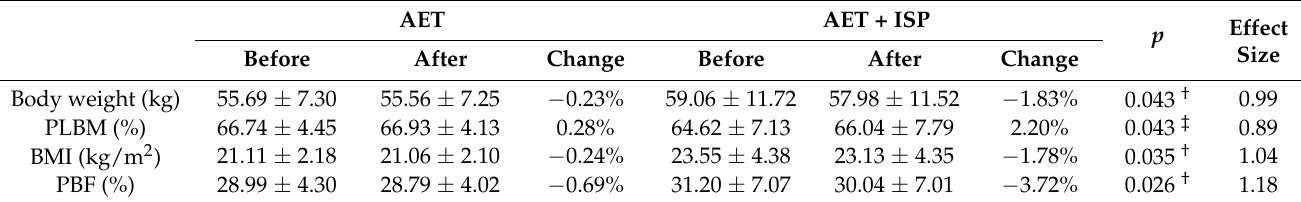
Table 3. The body composition of AET and AET + ISP groups before and after 8 weeks of intervention.